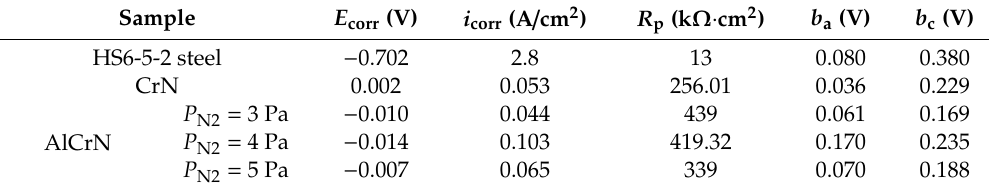
Figure 15. List of polarization curves for investigated coatings. Table 3. Summary of all calculated parameters of the potentiodynamic corrosion tests.